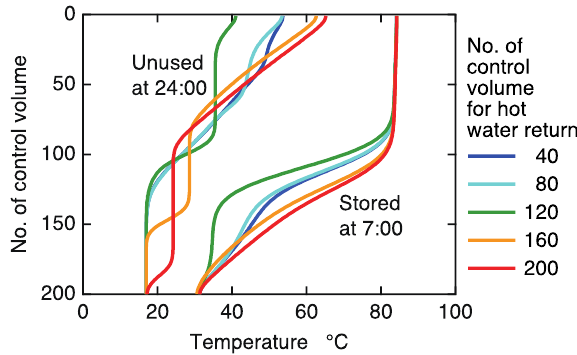
Figure 11. Influence of position for hot water return on temperature distributions.